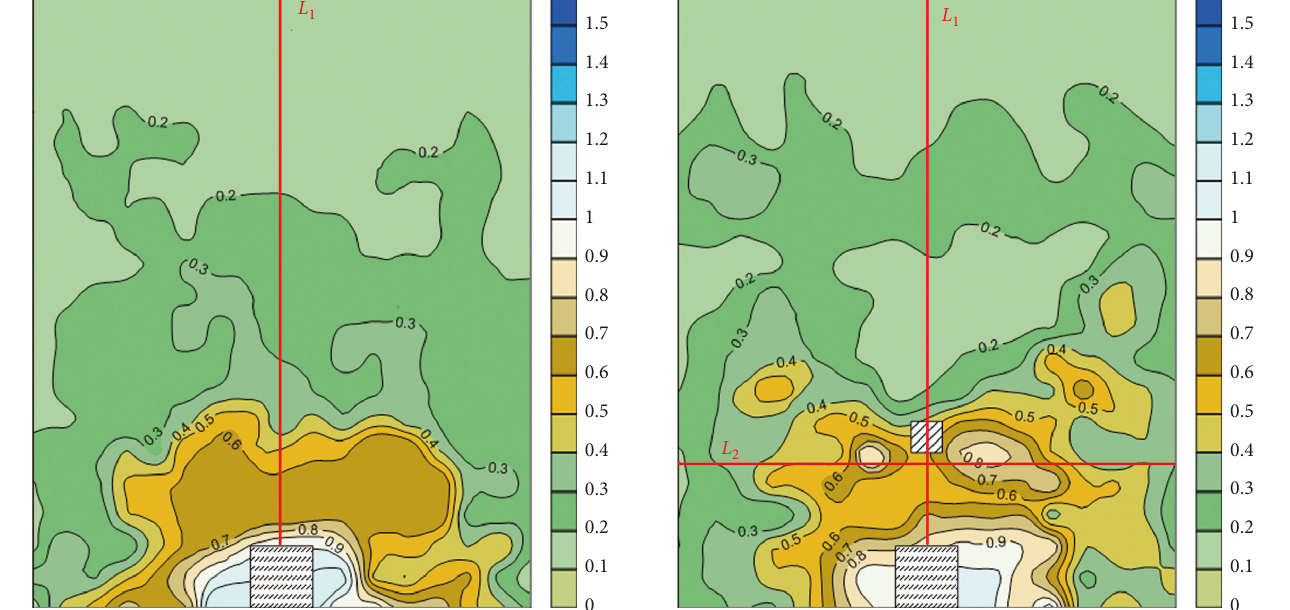
Figure 10: The contour map of ζ on